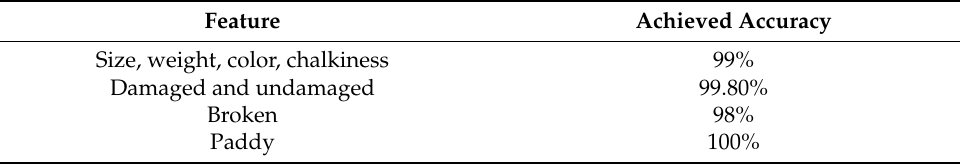
Table 3. Prediction accuracy achieved for the seven features of